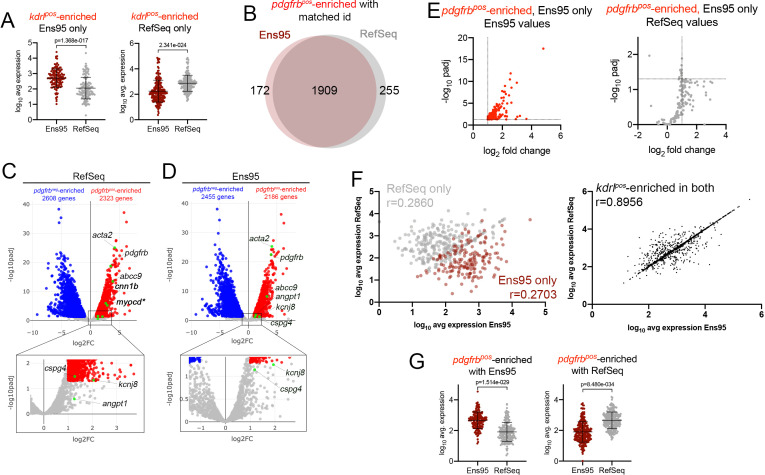
Comparison of Ens95 and RefSeq zebrafish transcriptome annotations for bulk RNA-seq analysis.(A) Log10 average expression (n = 3) for kdrlpos-enriched genes as quantified by each indicated annotation. Each separate plot shows genes identified as kdrlpos-enriched only using or Ens95 or RefSeq. Data are not normally distributed, Wilcoxon matched-pairs signed-rank test, p values are indicated. (B) Venn diagram of intersection for genes with a common NCBI ID in Ens95 and RefSeq found significantly enriched in pdgfrbpos cells (log2 fold change [pdgfrbpos/pdgfrbneg]>1,adjp <0.05) using each annotation. (C, D) Volcano plots showing differentially expressed genes from TgBAC(pdgfrb:citrine)s1010-positive and negative cells identified using RNA-seq reads quantified using (C) RefSeq or (D) Ens95 annotations. Genes with significant differences (padj <0.05) are shown as red (log2 fold change >1) or blue (log2 fold change<-1). Grey dots are genes that fall below these statistical cutoffs; n = 3. Green dots indicate selected genes previously identified as expressed in vascular smooth muscle cells or pericytes (see main text). (E) Plots of commonly annotated genes identified as pdgfrbpos-enriched only by Ens95 with indicated values from Ens95 or RefSeq. (F) Correlation of expression levels from indicated annotation for pdgfrbpos-enriched genes identified selectively as such by Ens95 (maroon) or RefSeq (grey) only (left plot) or in both annotations (right plot). Data are not normally distributed, Spearman correlation, r values are indicated. (G) Log10 average expression (n = 3) for pdgfrbpos-enriched genes as quantified by each indicated annotation. Each separate plot shows genes only identified as pdgfrbpos-enriched using Ens95 or RefSeq. Data are not normally distributed, Wilcoxon matched-pairs signed-rank test, p values are indicated.Figure 1—figure supplement 1—source data 1.DESeq2 output for pdgfrbpos and pdgfrbneg RNA-seq quantified with RefSeq (GCF_000002035.6_GRCz11) or Ensembl, v95.Gene expression levels were quantified using RSEM. Median ratio normalized expression values are shown for each replicate, along with adjusted p-value, and log2 fold change. Data used to generate plots in Figure 1—figure supplement 1C–E, and incorporated into source data tables indicated below.Figure 1—figure supplement 1—source data 2.Intersection of pdgfrbpos-enriched genes from RefSeq and Ens95 commonly annotated by NCBI ID.Gene symbol, along with matching Ensembl gene ID and NCBI ID, as well as differential annotation (i.e., identified as differentially expressed only in RefSeq, Ens95, or both) are indicated. Expression data are derived from Figure 1—source data 1. Data used to generate plots in Figure 1—figure supplement 1B,F–H.